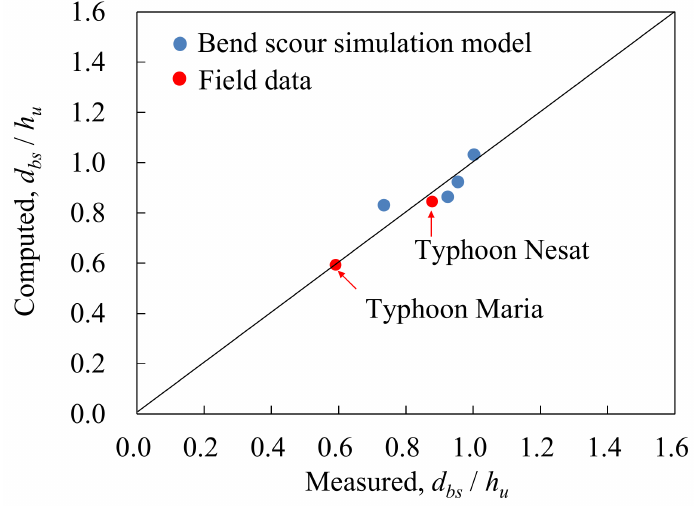
Figure 19. Computed and measured d bs / h u with an R 2 value of